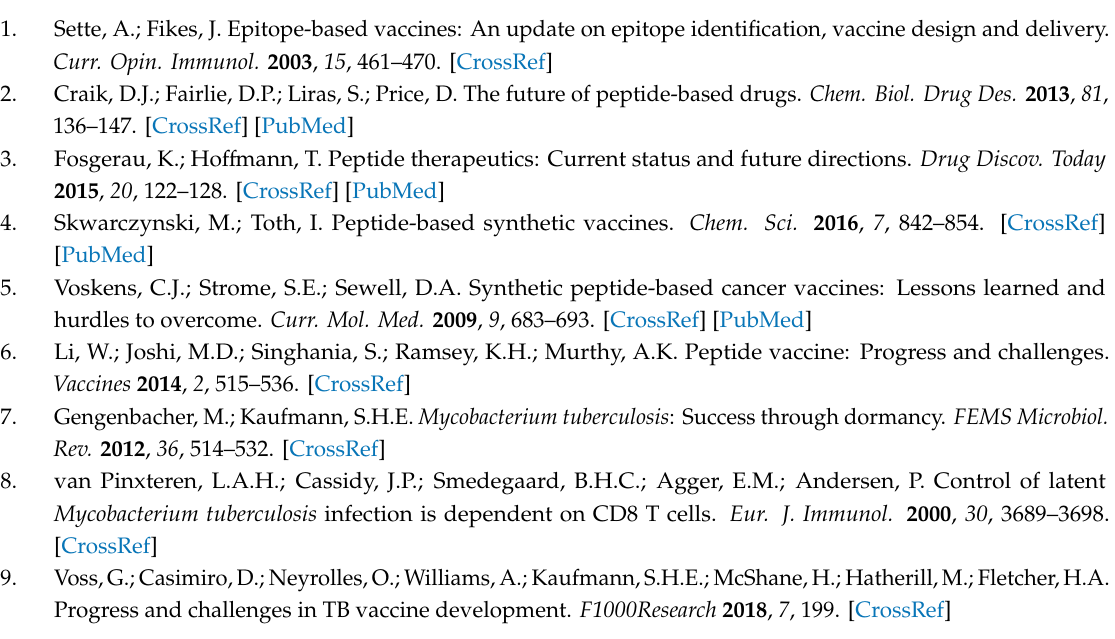
Table S1: Methods and results of the hemolytic and cytotoxicity assays, Figure S1: gating strategy applied in the cellular uptake measurement;, Figure S2: flow cytometry histograms of the splenocyte proliferation assay. Author Contributions: Conceptualization, K.H.; methodology, K.H., B.P., K.F., B.S.; validation, B.P., K.F.,